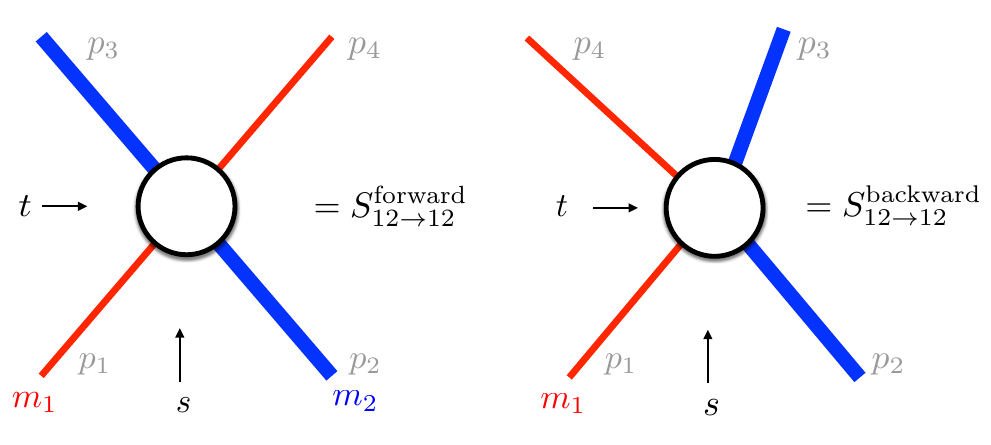
Figure 5. In two dimensions when we scatter two particles m a and m b from the in(cid:12)nite past with m a to the left of m b we can end up, in the in(cid:12)nite future with m a to the right of m b or vice-versa. If the particles are distinguishable these are two genuinely di(cid:11)erent processes denoted as the forward or backward process. (They are sometimes also called the transmission and re(cid:13)ection processes.) In higher dimensions, these two scenarios are limiting values of the a single amplitude when the scattering angle tends to (cid:18) = 0 or (cid:18) = (cid:25) , but in two dimensions there is no scattering angle and these processes are described by independent functions. As we exchange time and space, i.e. as we analytically continue these processes by swapping t and s we see that the forward process is mapped to itself while the backward process as seen from its crossed channel describes the m a m a m b m b ! event. This translates into equations (2.15) and (2.16) in the main